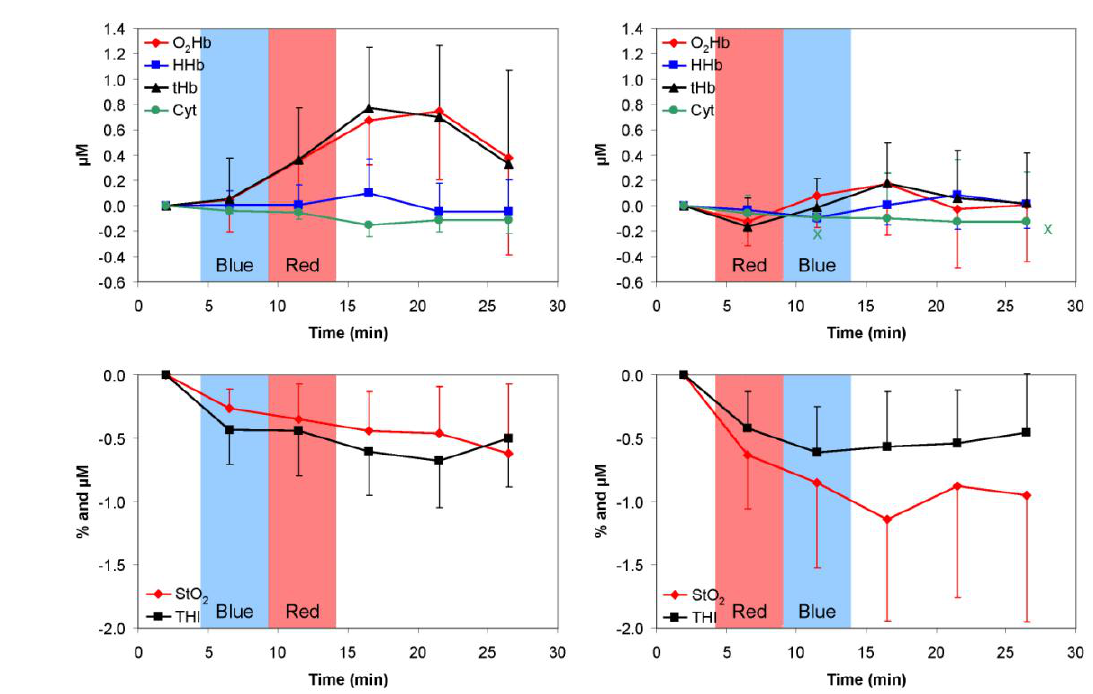
FIGURE 2. Brain: time evolution of the cerebral parameters. Left graphs: data from exposure to first blue and then to red light (shaded areas). Right graphs: data from exposure to first red then blue light (shaded areas). Upper graphs: NIRS parameters — O Hb = oxyhemoglobin, HHb = 2 deoxyhemoglobin, tHb = total hemoglobin, Cyt = cytochrome oxidase redox state. Lower graphs: NIRS parameters — StO = tissue oxygen saturation, THI = total hemoglobin concentration. All 2 parameters are shown relative to the baseline value before the exposure to colored light, which was set to zero. Two significant changes from baseline in Cyt are marked by an x ( p < 0.05). Although there were considerably larger changes in some of the parameters, these changes were not significant. The values show a large interindividual variability (the whiskers indicate the standard error of